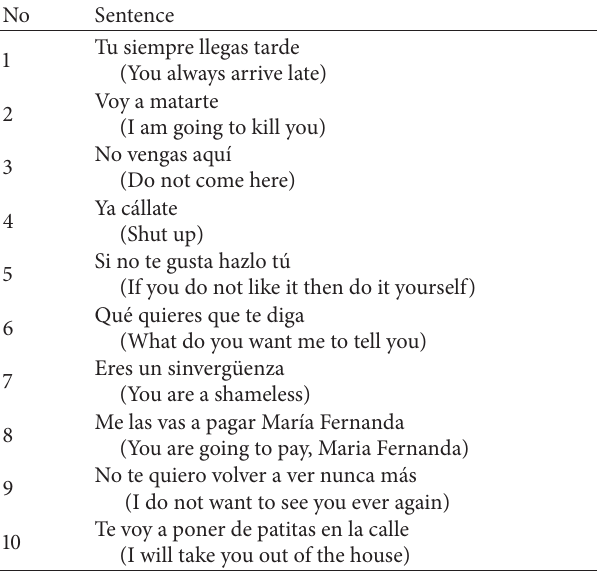
Table 1: Emotional stimuli: “enojo”